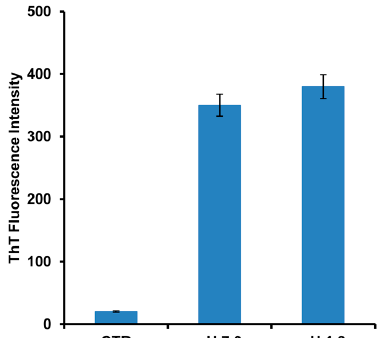
Figure 1. Amyloid fibrils formation in human insulin monitored by ThT fluorescence. Protein was analyzed after 24 h of incubation in aggregating conditions at pH 7.0 and pH 1.8. Control (CTR) refers to the protein in native conditions. Data are expressed as average ± S.D. from five independent experiments carried out in triplicate ( p < 0.01). Experimental details are described in the Materials and Methods section.